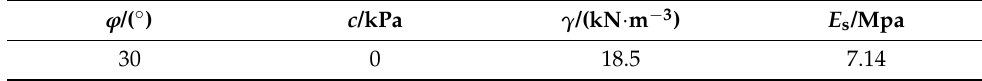
Figure 12. Relation curve between shear strength and vertical pressure.